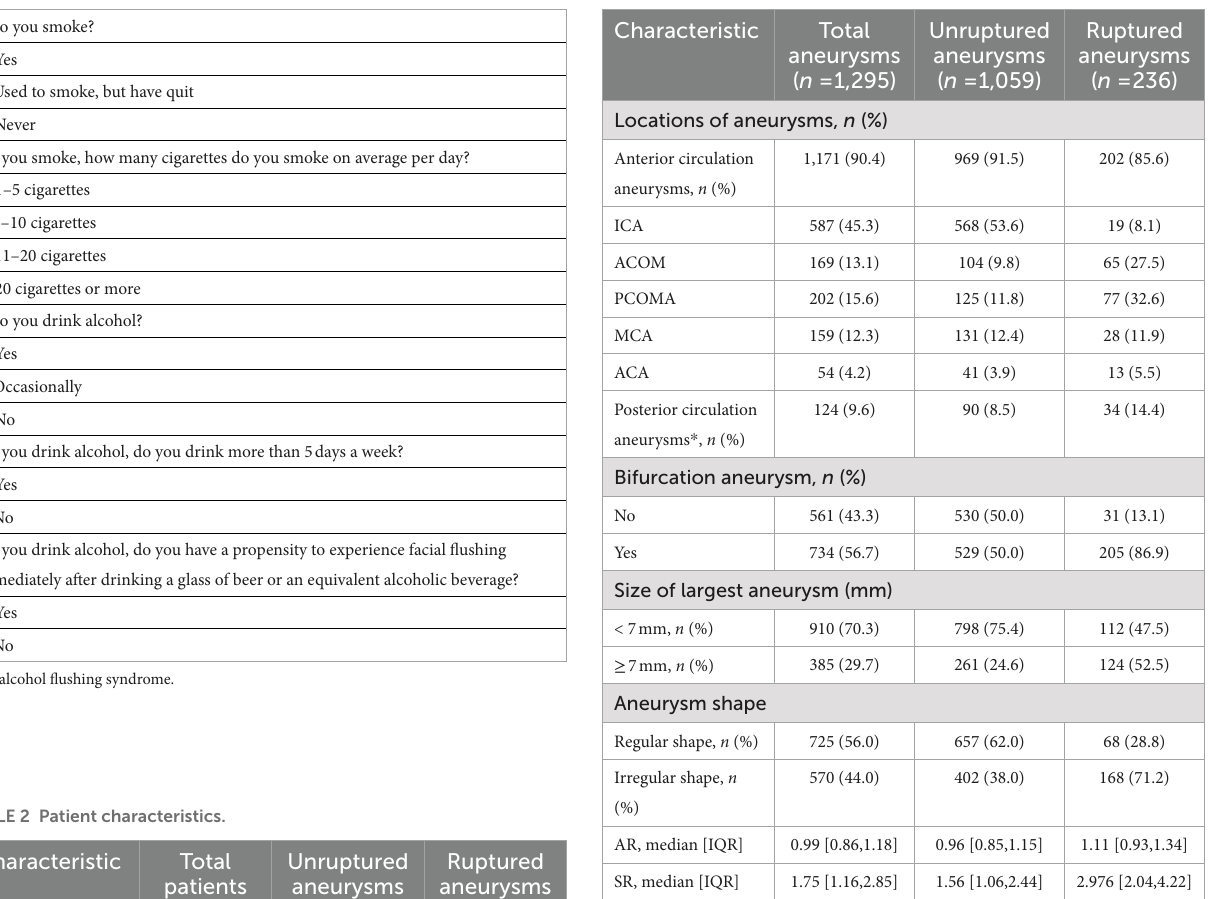
TABLE 1 The AFS questionnaire.